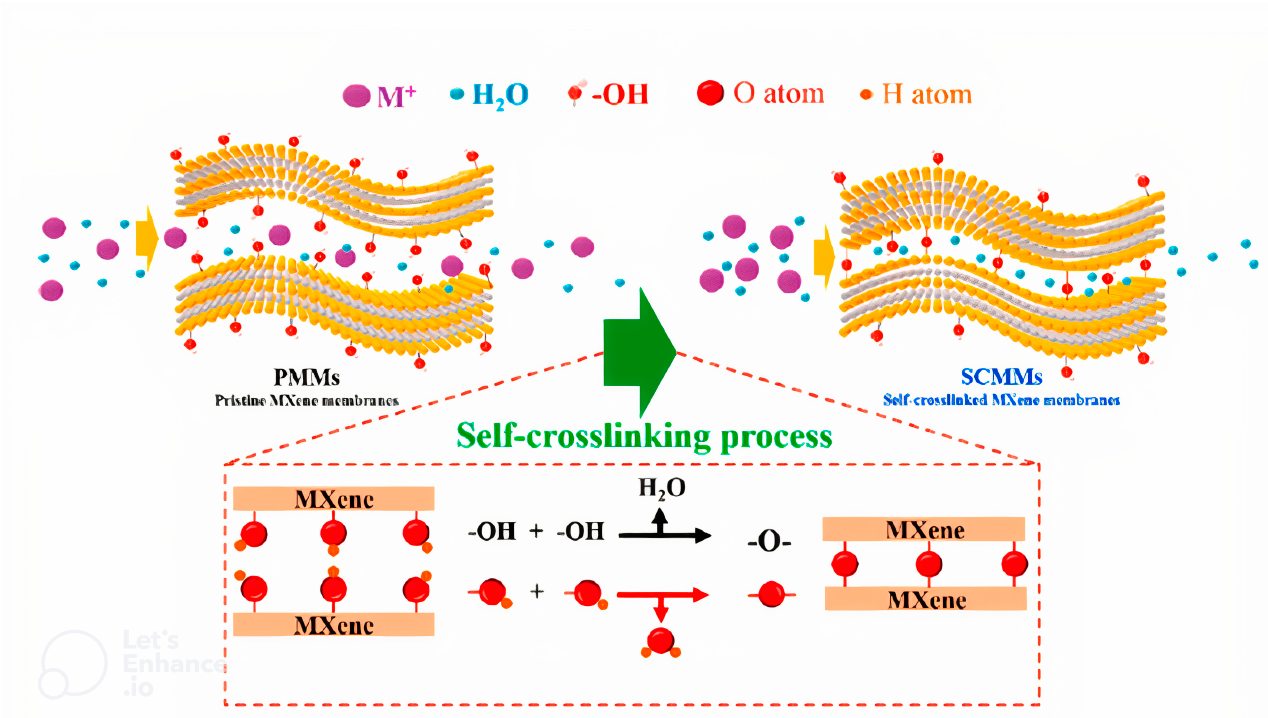
Figure 12. Structure of modified Ti 3 C 2 T x -based nanofiltration membranes. C: Self-crosslinked Ti 3 C 2 T x [221].